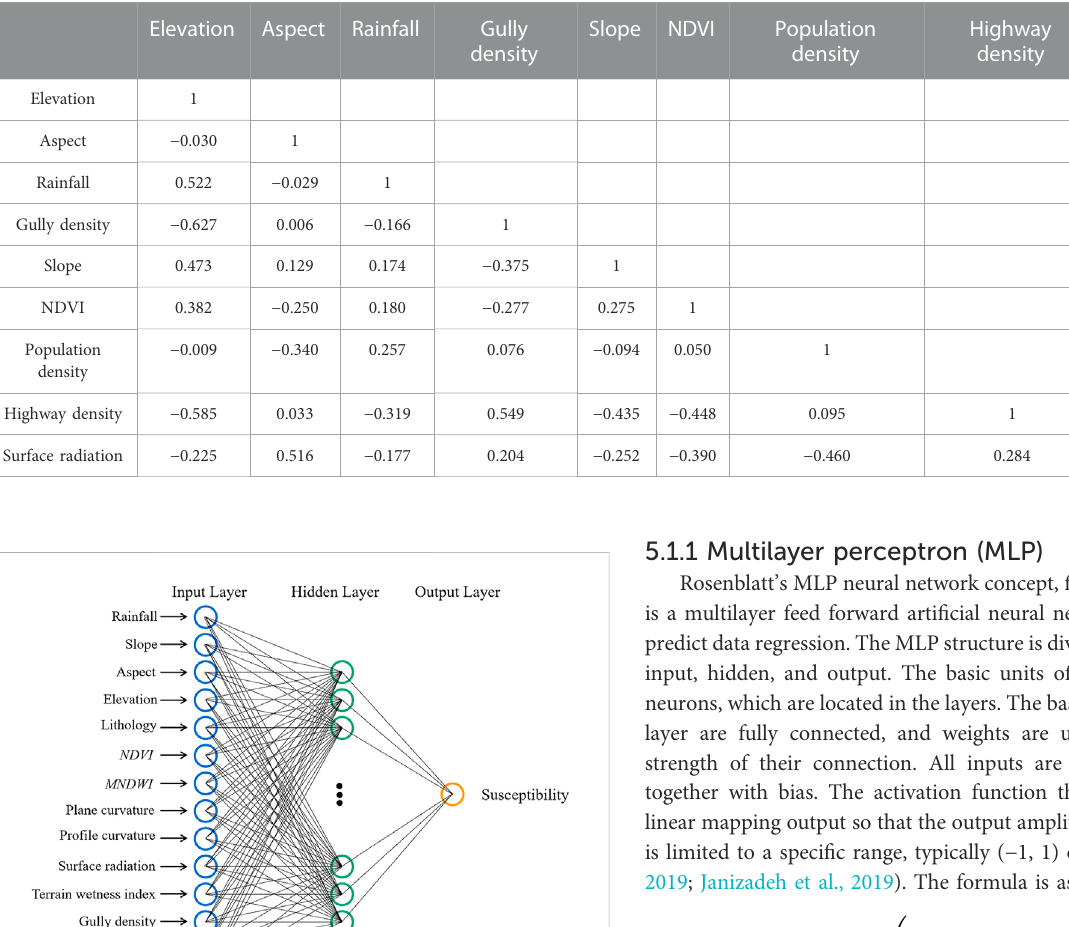
TABLE 2 Correlation coef fi cient matrix diagram of some environmental factors.